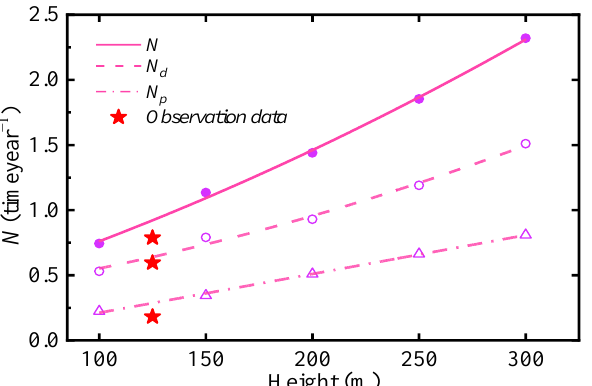
Figure 12. The annual lightning flash number for the wind turbines at different heights by +CG (dashdot line), − CG (dash line) and all the downward lightning (solid line).